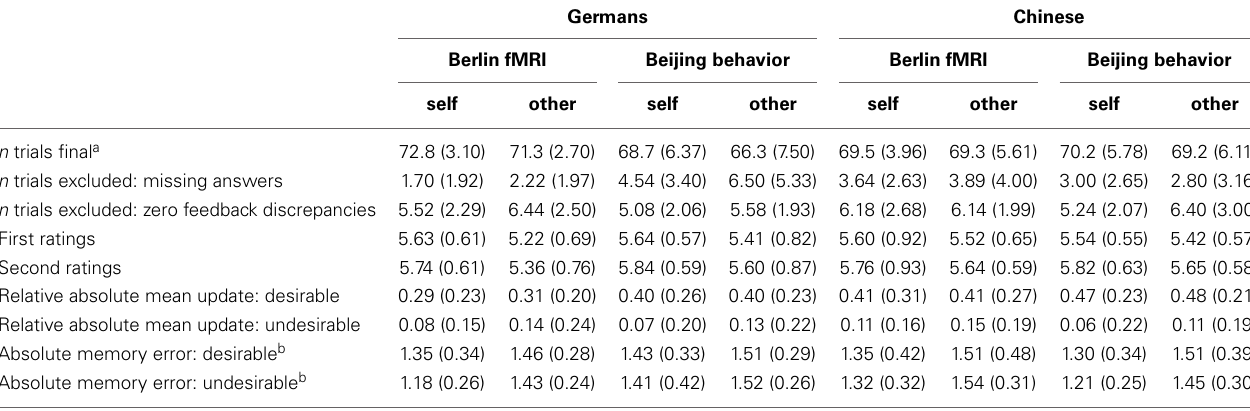
Table 2 | Task-related